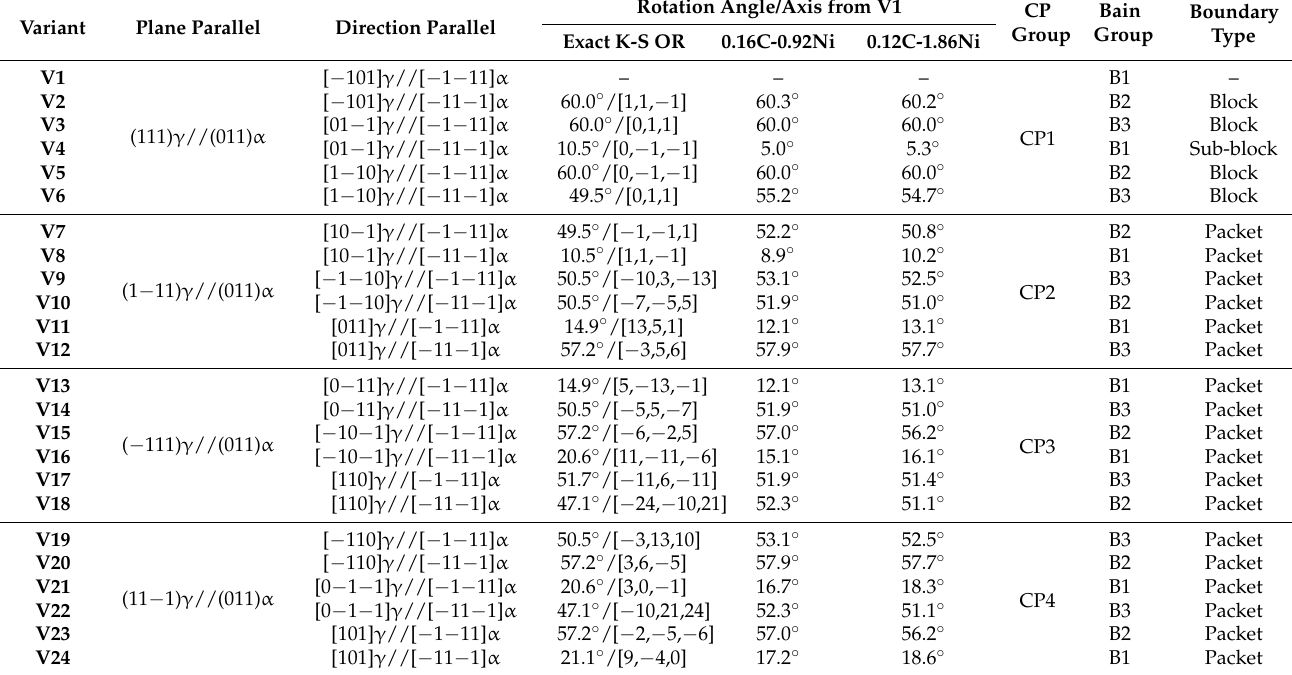
Table 4. Misorientation axes and angles between V1 and the other variants calculated from the experimentally determined OR (actual OR), and the inter-variant boundary characteristics [24,30].